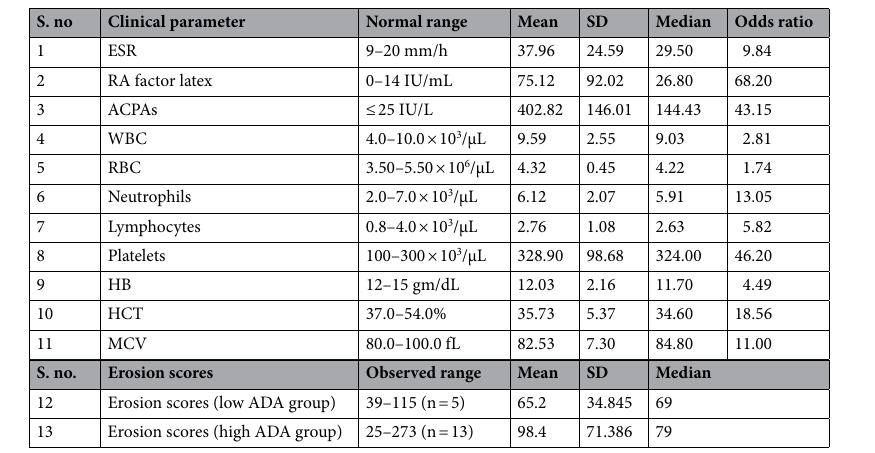
Table 2. Altered levels of clinical parameters in RA